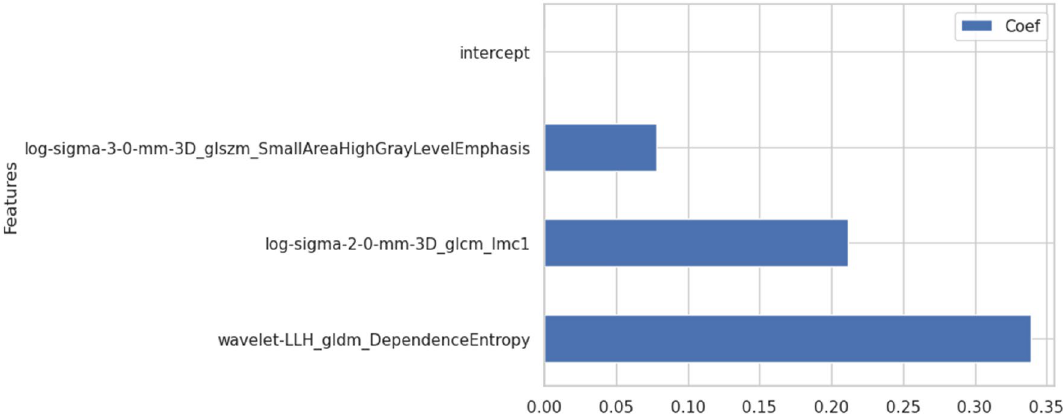
Figure 3. Coefficients of the peritumoral radiomics model.